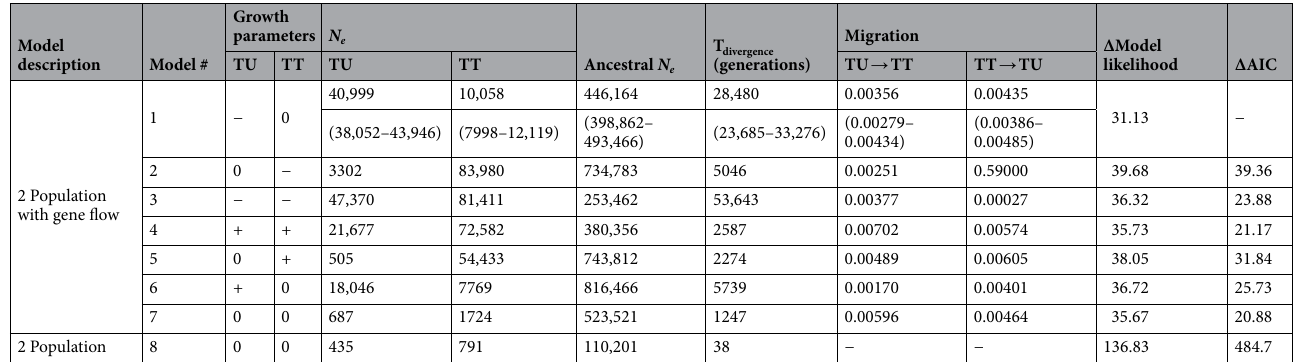
Table 3. Demographic modeling parameter estimates for each of eight 2-population models. TU refers to Tugur mainstem, while TT refers to Tugur tributaries. Growth parameters for each population represent expansion (+), contraction (−), and no change (0) following the ancestral divergence. Model numbers correspond to those in Fig. 4 For the best fit model (model 1), 95% confidence intervals are given in